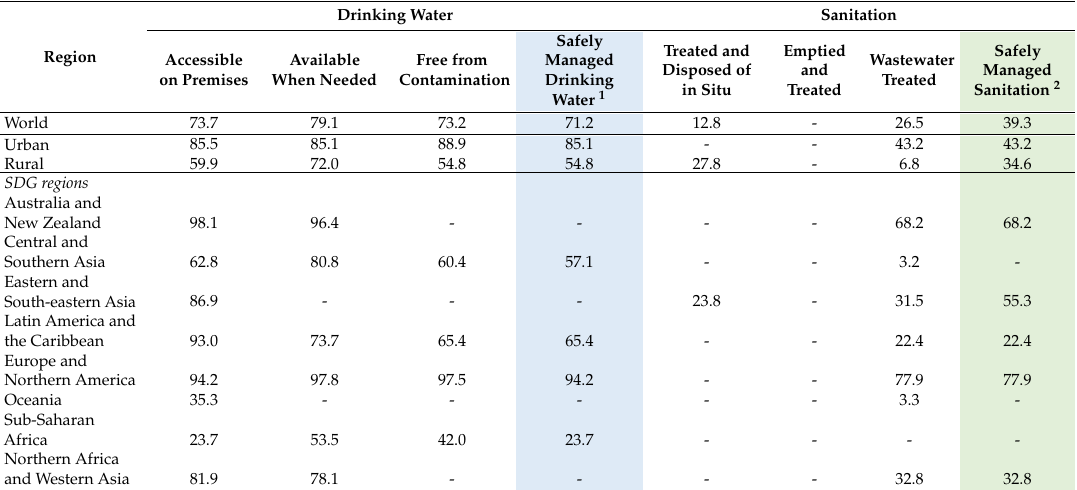
Table 6. Safely managed elements and estimates globally and by SDG region. Drinking Water Sanitation Region Accessible Available Free from on Premises When Needed Contamination